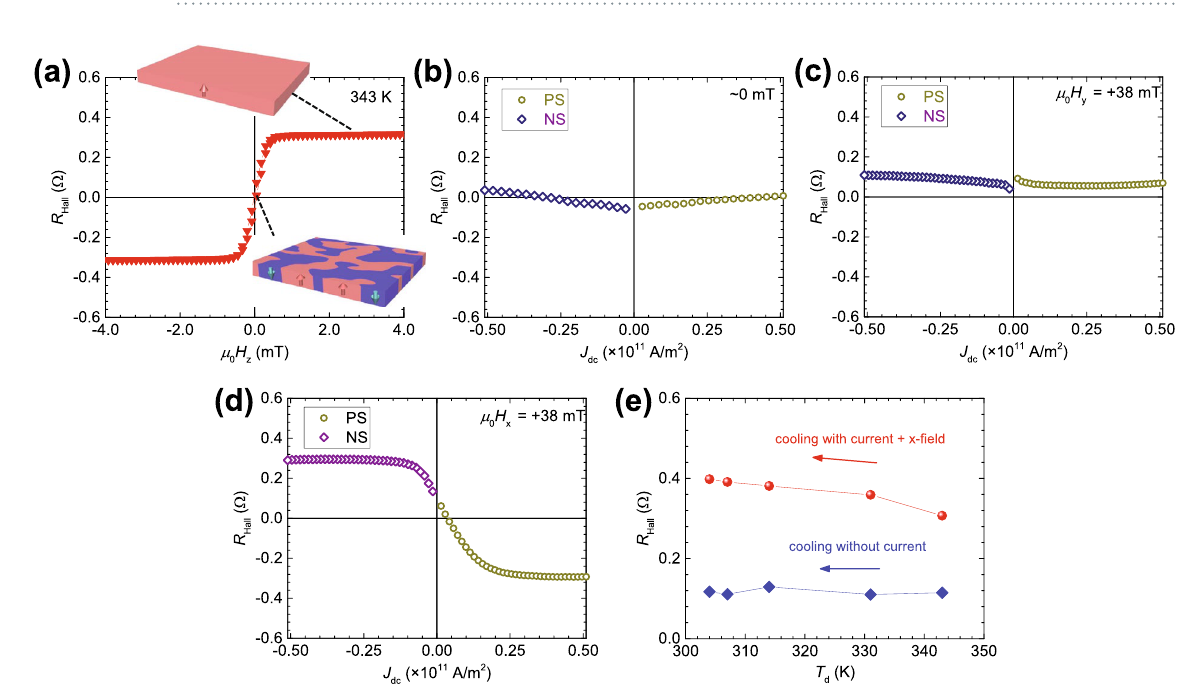
Figure 3. Current sweep measurement under 343 K. ( a ) μ 0 H z – R Hall curve obtained at stage temperature T d of 343 K. J dc of + 2.8 × 10 9 A/m 2 is used for the measurement. ( b–d ) J dc dependences of R Hall measured under ( b ) 0 T, ( c ) μ 0 H y , and ( d ) μ 0 H x of + 38 mT, respectively. Yellow (purple) points indicate results for the positive (negative) current sweep. ( e ) Results of T d cooling experiment. T d is reduced from 343 K to 304 K with injecting J dc of − 0.25 × 10 11 (red) and − 2.8 × 10 9 A/m 2 (blue) under μ 0 H x = + 38 mT. The error bar, which is the standard deviation of two data points, is smaller than the